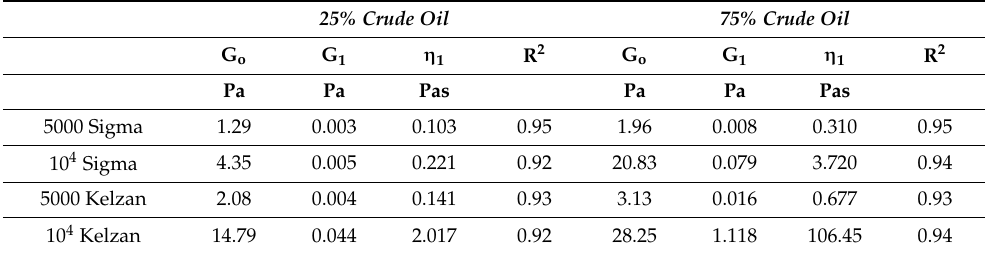
Table 4. Results of recovery analysis using Equation (10) for higher gum